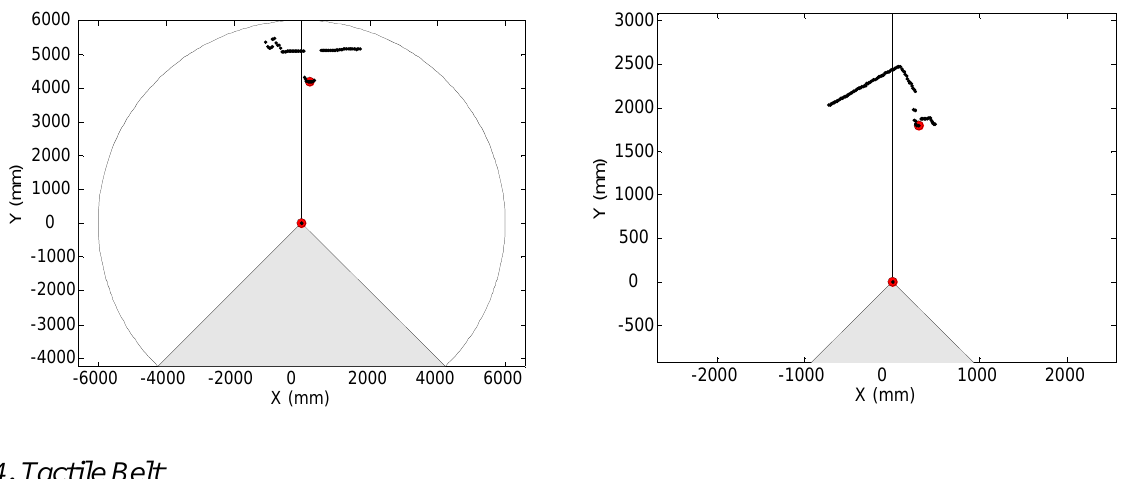
Figure 18. Example of partial scans analyzed in frontal mode. The closest obstacle (left at 4,188 mm, right at 1,795 mm) is located and labeled with a red circle.